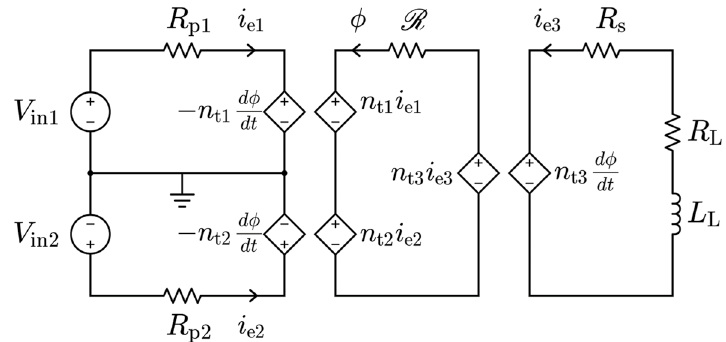
Fig. 14 Output stage of a vacuum tube guitar amplifier including a multiphysics transformer model